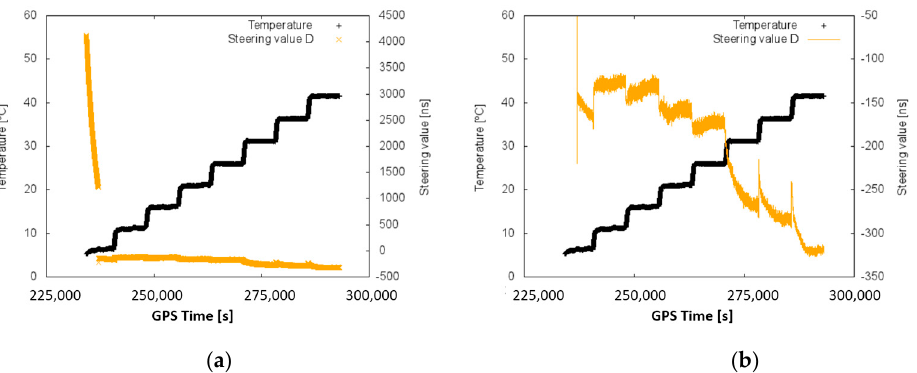
Figure 9. Steering and temperature vs. time ( a ). Steering values zoomed only in the right-side vertical axis ( b ). Temperature and time axes are constant in both cases.